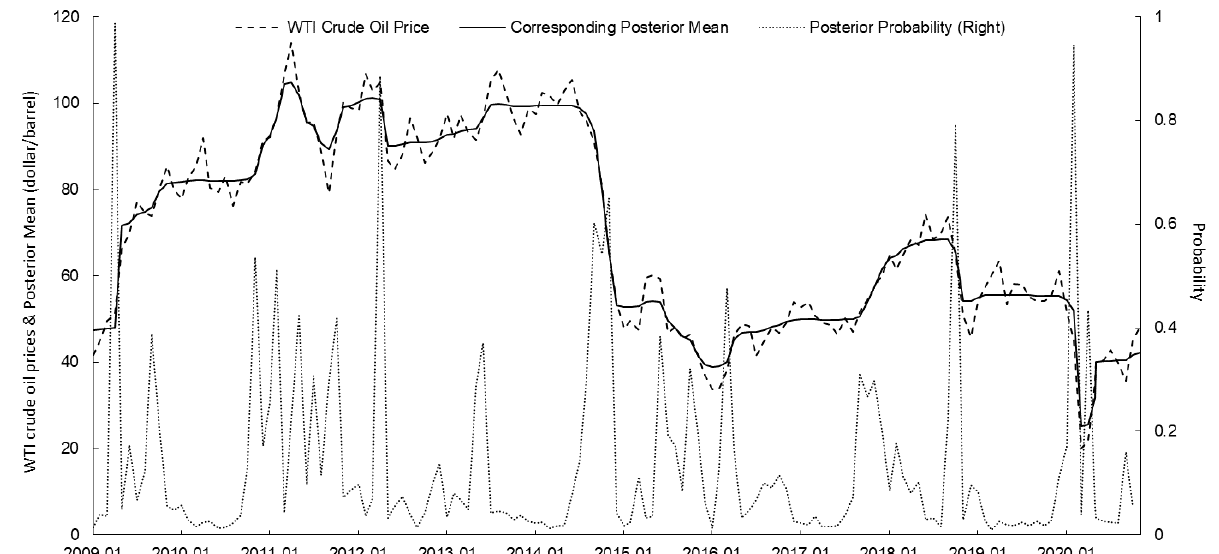
Figure 1. PPM calculation results of WTI crude oil prices and corresponding posterior mean and posterior probability since 2009 (source: NYMEX).